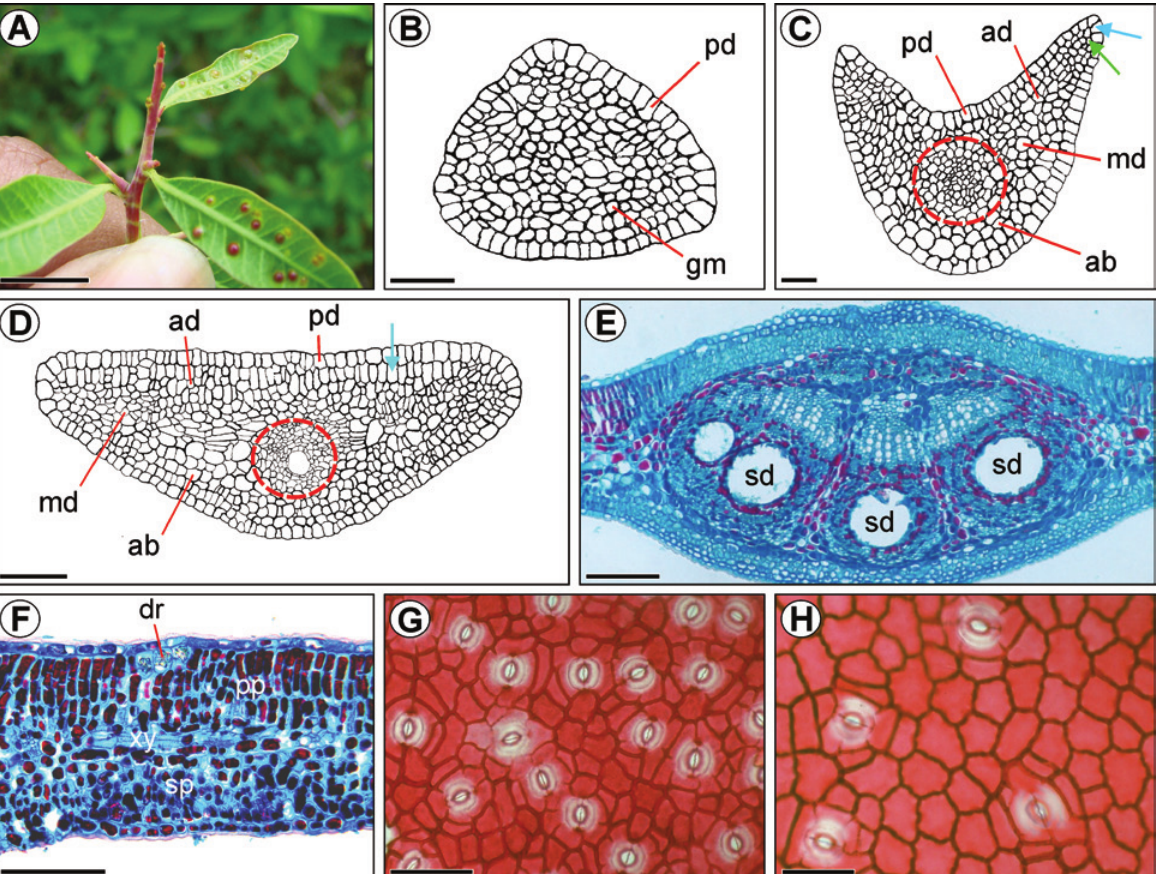
Fig. 1 - Development of the leaves of Schinus polygamus : A) Shoot apex with spiral alternate phyllotaxy; B-D) Diagrams of a leaf primordium in transverse section at the first, second and fourth nodes, respectively; in C, the red circle indicates the procambium, and the arrows, the marginal (blue) and submarginal (green) initials; in D, the palisade parenchyma begins to elongate (blue arrow) and the procambium (red circle) divides periclinally, originating the vascular bundle with the secretory duct; E) Midrib of the completely expanded leaf; sixth node; F) Dorsiventral mesophyll of mature leaf lamina, with the palisade parenchyma facing the adaxial surface and the 6-8 layered, spongy parenchyma; G) Abaxial epidermal surface, with anomocytic stomata; H) Adaxial epidermal surface, with fewer stomata than the abaxial surface. ab = abaxial meristem; ad = adaxial meristem; dr = druses; md = median meristem; gm = ground meristem; pd = protoderm; pp = palisade parenchyma; sd = secretory duct; sp = spongy parenchyma; xy = xylem. Bars = 1 cm and 20, 20, 60, 100, 100, 25, 25 µm,